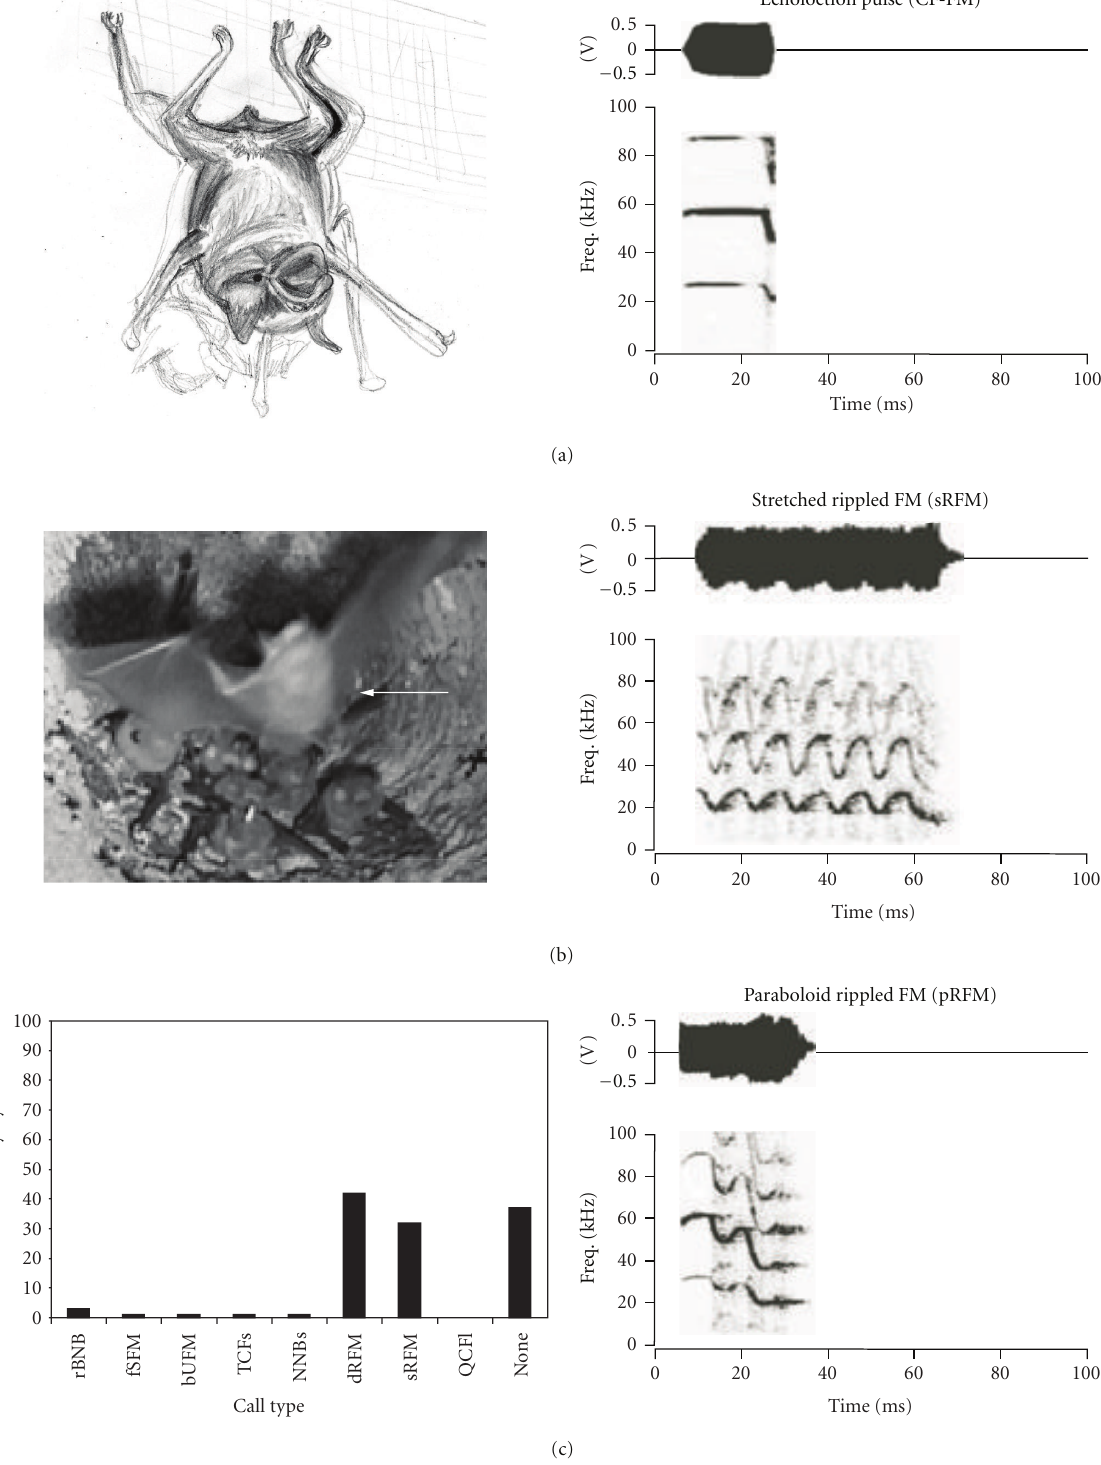
Figure 7: Echolocation and flying behavior in mustached bats. (a) A sketch showing the typical posture of roosting bat echolocating to inspect its surroundings. The amplitude envelope (above) and spectrogram (below) of the echolocation pulse are shown on the right. (b) A photograph of a bat (indicated by the white arrow) flying by a small cluster of bats roosting in an upside-down pot attached to the ceiling. Bats are viewed from below. Amplitude envelopes and spectrograms of the calls emitted during this behavior are shown in the two panels on the right. (c) A bar graph showing the frequency of occurrence of di ff erent call types during a